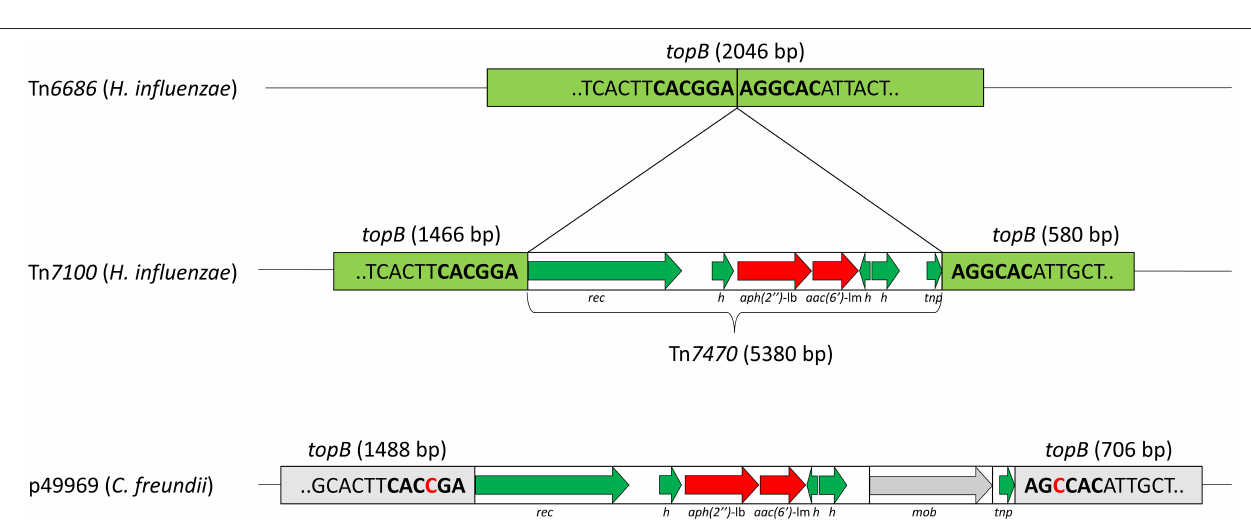
identity) or downstream of this gene (85.63% identity). The terminal seven bases in Tn 7471 were identical to Tn 6822 (TTTGTTT), while the downstream coupling sequence, which is transferred with the transposon from the previous host (Rudy and Scott, 1994), differed between Tn 7100 and S. pneumoniae strain